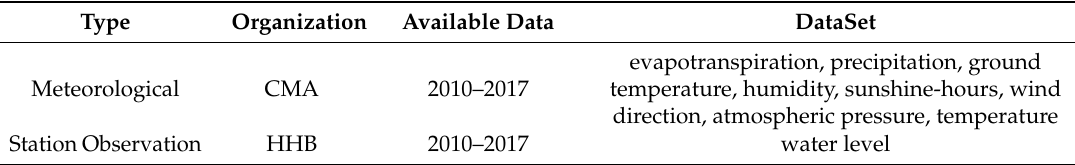
Table 1. The information of the used data sets.